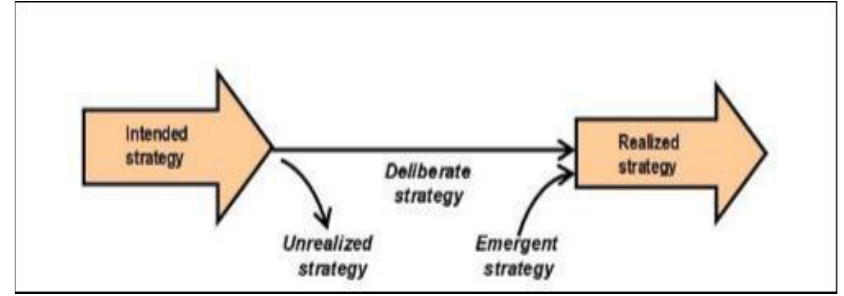
Figure 1: Models of Strategic Decision Making; Source: Mirabeau & Maguire,